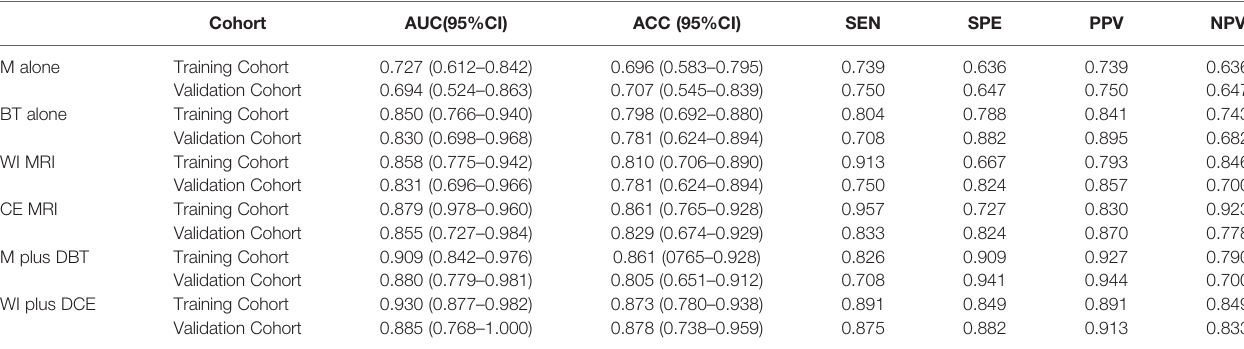
TABLE 2 | Diagnostic performance of each modality used alone and in